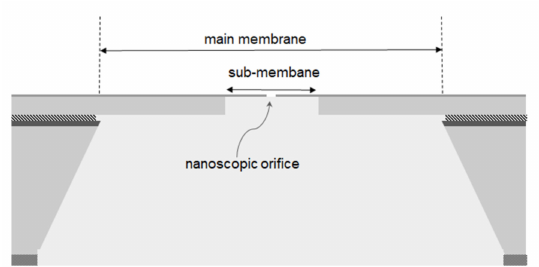
Figure 1. Membrane-in-membrane